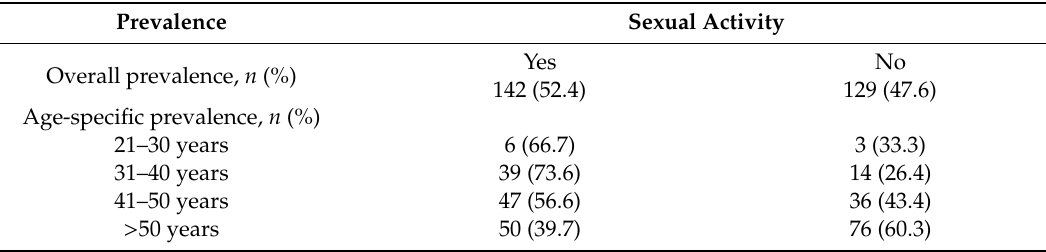
Table 1. The age-specific prevalence of sexual activity in the sample population ( n =